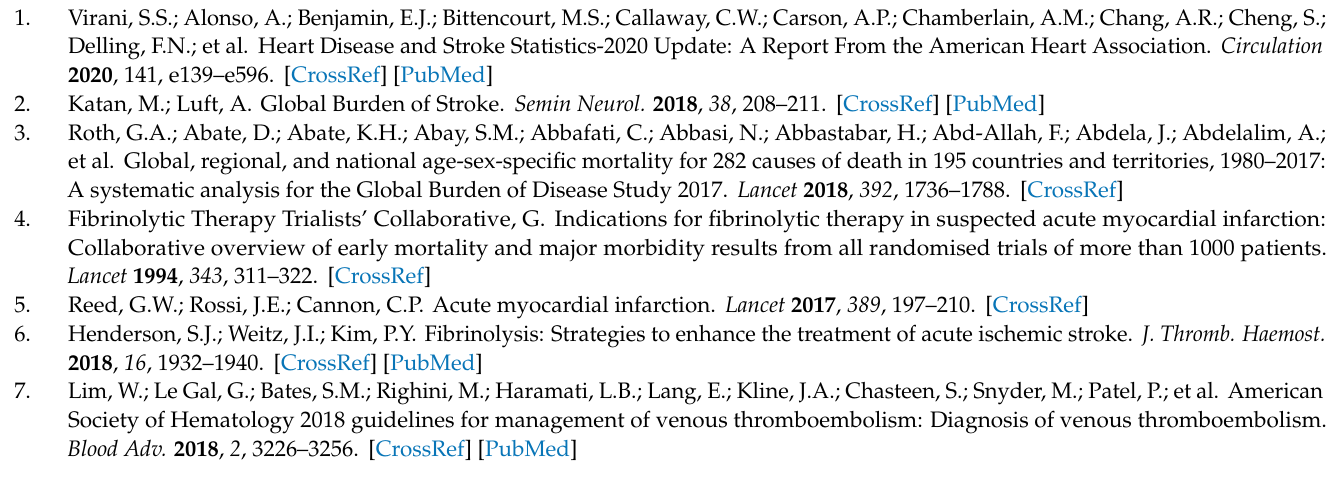
LisB. Figure S2: In vitro probe depletion. Figure S3: Radio-chromatogram of 111 In-A16 after radio- HPLC analysis. Figure S4: Representative SPECT/CT overlay of a mouse 6 hr after IVC